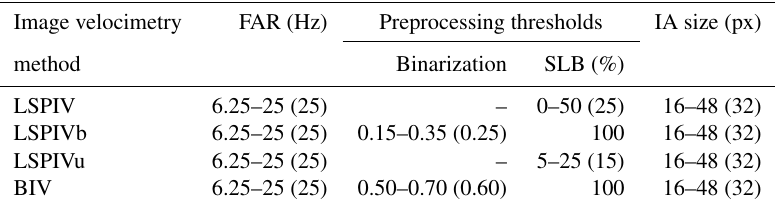
Table 1. Ranges of the parameters considered in the analysis of the different image velocimetry methods. Values in parentheses specify the base value of the parameters used as